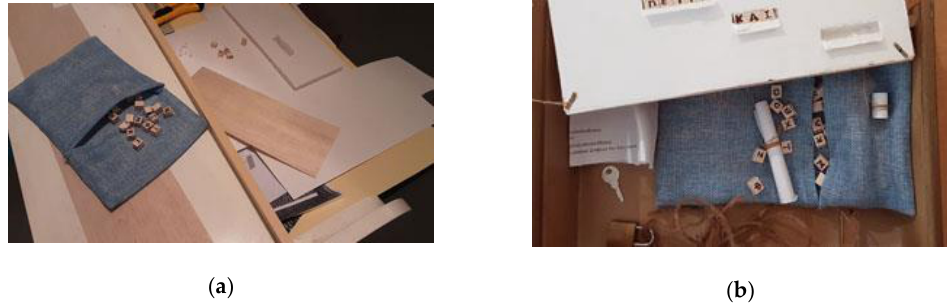
Figure 3. ( a ) Constructing the foam board label and the wooden cubes with letters; ( b ) The key, the box, the math’s quiz,